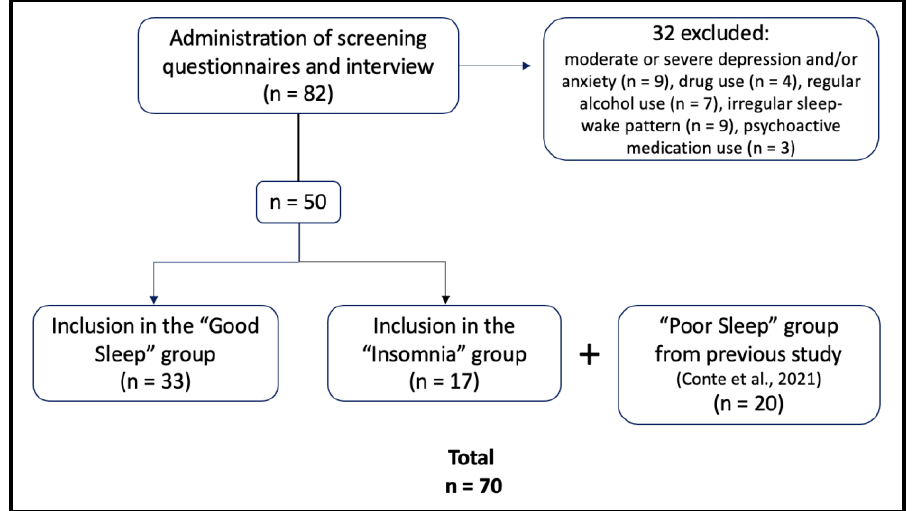
Figure 1. Flowchart of the recruitment process. Data on participants of the “Poor Sleep” group analyzed here come from a previous study of our group [16].